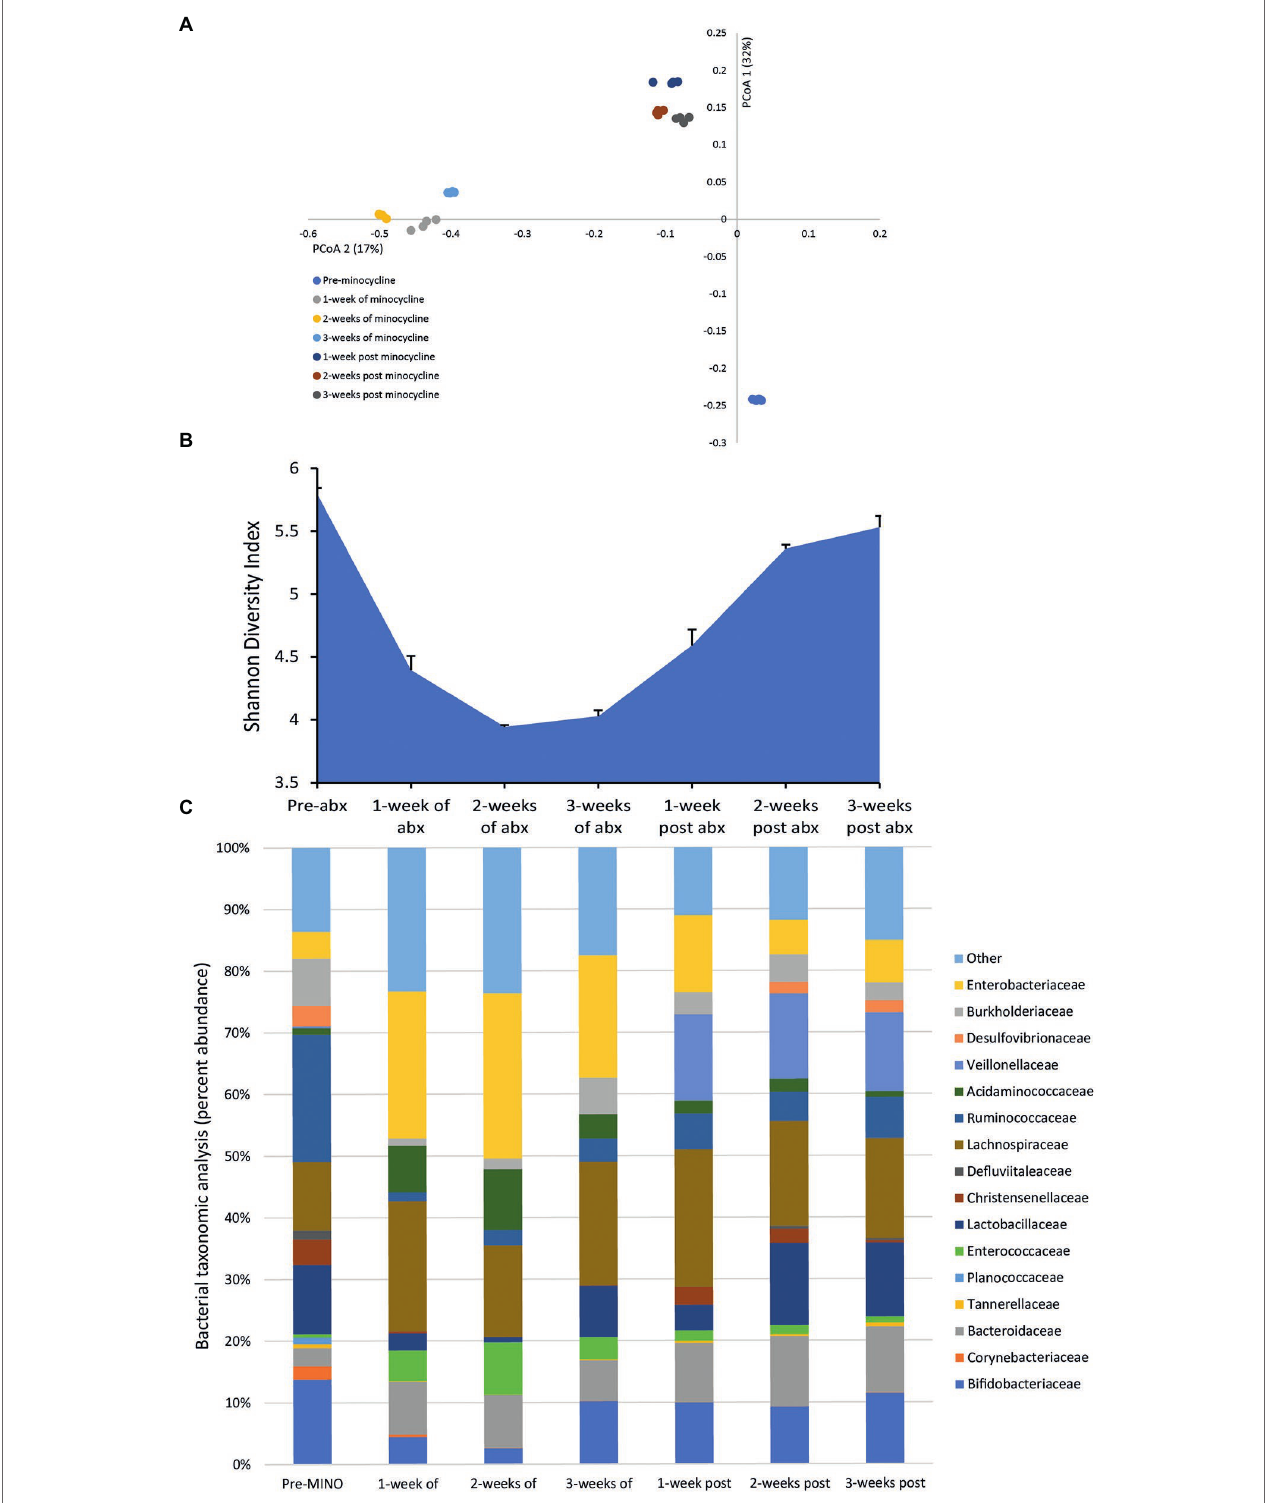
FIGURE 3 | Effect of minocycline on the human microbiota. Changes to the microbiota profile during each week of minocycline instillation and the recovery phase shown as a Principal Coordinate Analysis plot (A) . Results shown are four technical replicates. Changes in the microbial diversity after exposure to minocycline and the recovery phase, as measured by the Shannon diversity index from four technical replicates (B) . Bacterial taxonomic abundance changes in response to minocycline instillation (C) . Stacked bar graphs are mean percent abundance, from four technical replicates, analyzed from 16S rRNA